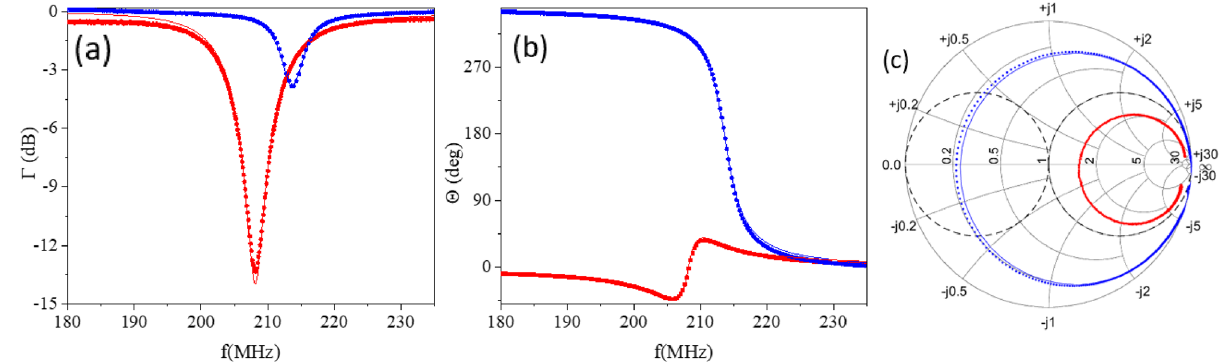
Figure 4. Results of reflectometry measurements at T=300K and 3.6K for MN composed of L=820 nH inductor and C pad with no DUT present; error-corrected data are shown: ( a ) magnitude measurements; ( b ) phase measurements; ( c )-Smith chart. Dots—experiment, solid lines—calculations. Red: 300 K, blue: 3.6 K. Simulations are performed based on 820 nH inductor Coilcraft model 15 adjusted for low